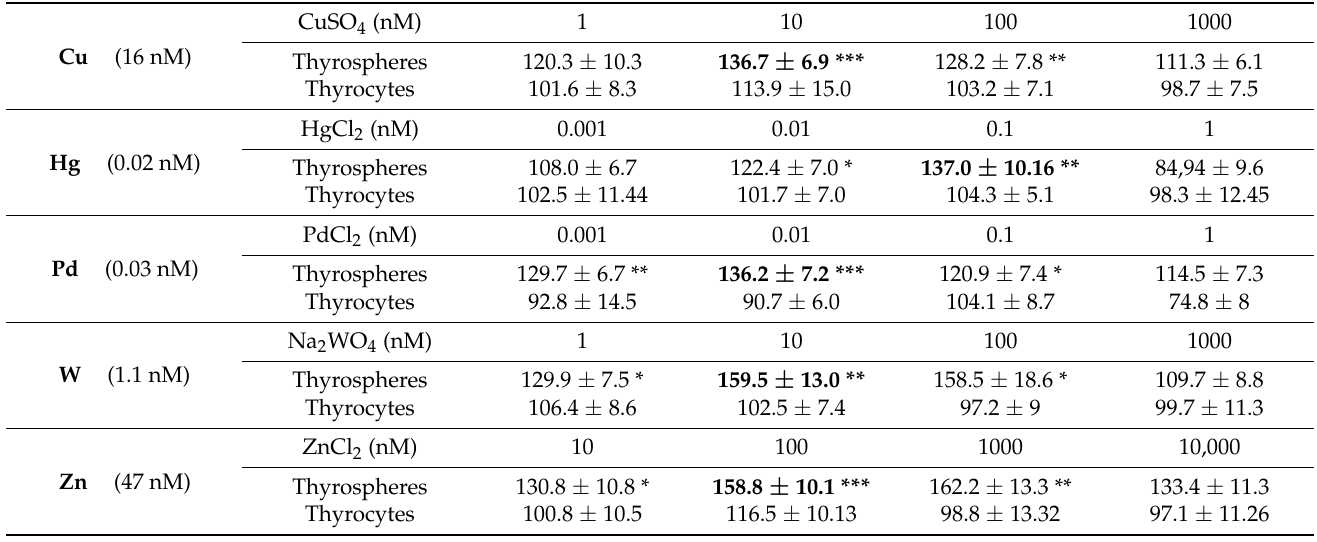
Table 1. Chronic exposure (3 days) to the indicated metals increased proliferation (BrdU incorporation) in human thyrospheres (stem/precursor thyroid cells) but not in mature thyrocytes in primary culture.